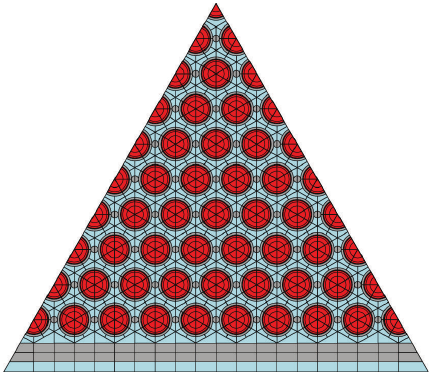
Figure 1: 1/6 of the reference fuel element geometry corresponding